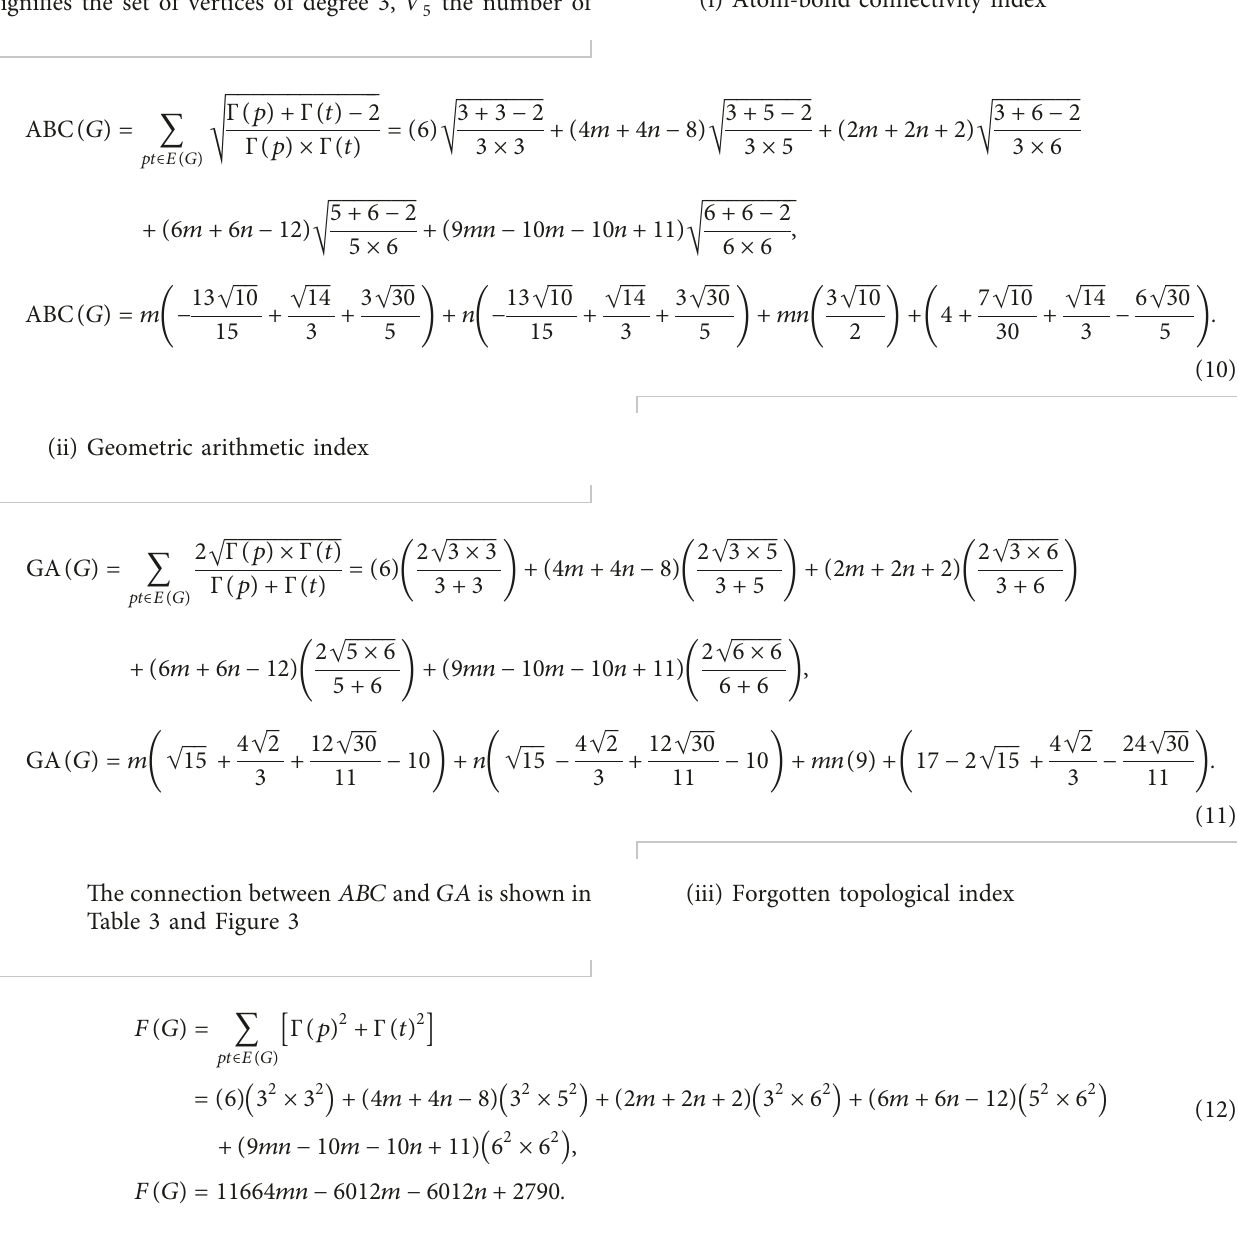
Figure 2: Structure of antimony telluride Sb [ 3 , 2 ] , two rows are being connected each with three-unit Te Sb 2 3 cells